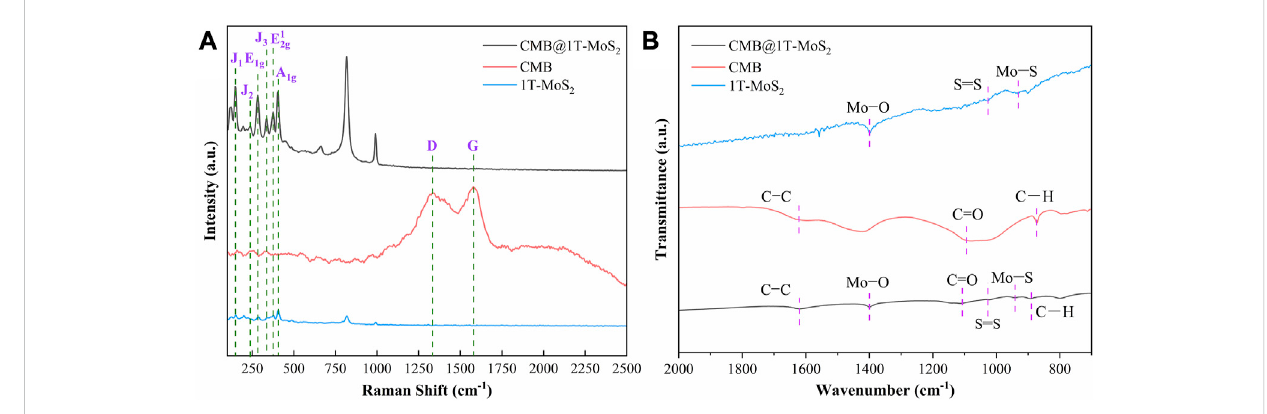
FIGURE 2 (A) Raman spectra and (B) FT-IR spectra of CMB@1T-MoS 2 , CMB, and 1T-MoS 2